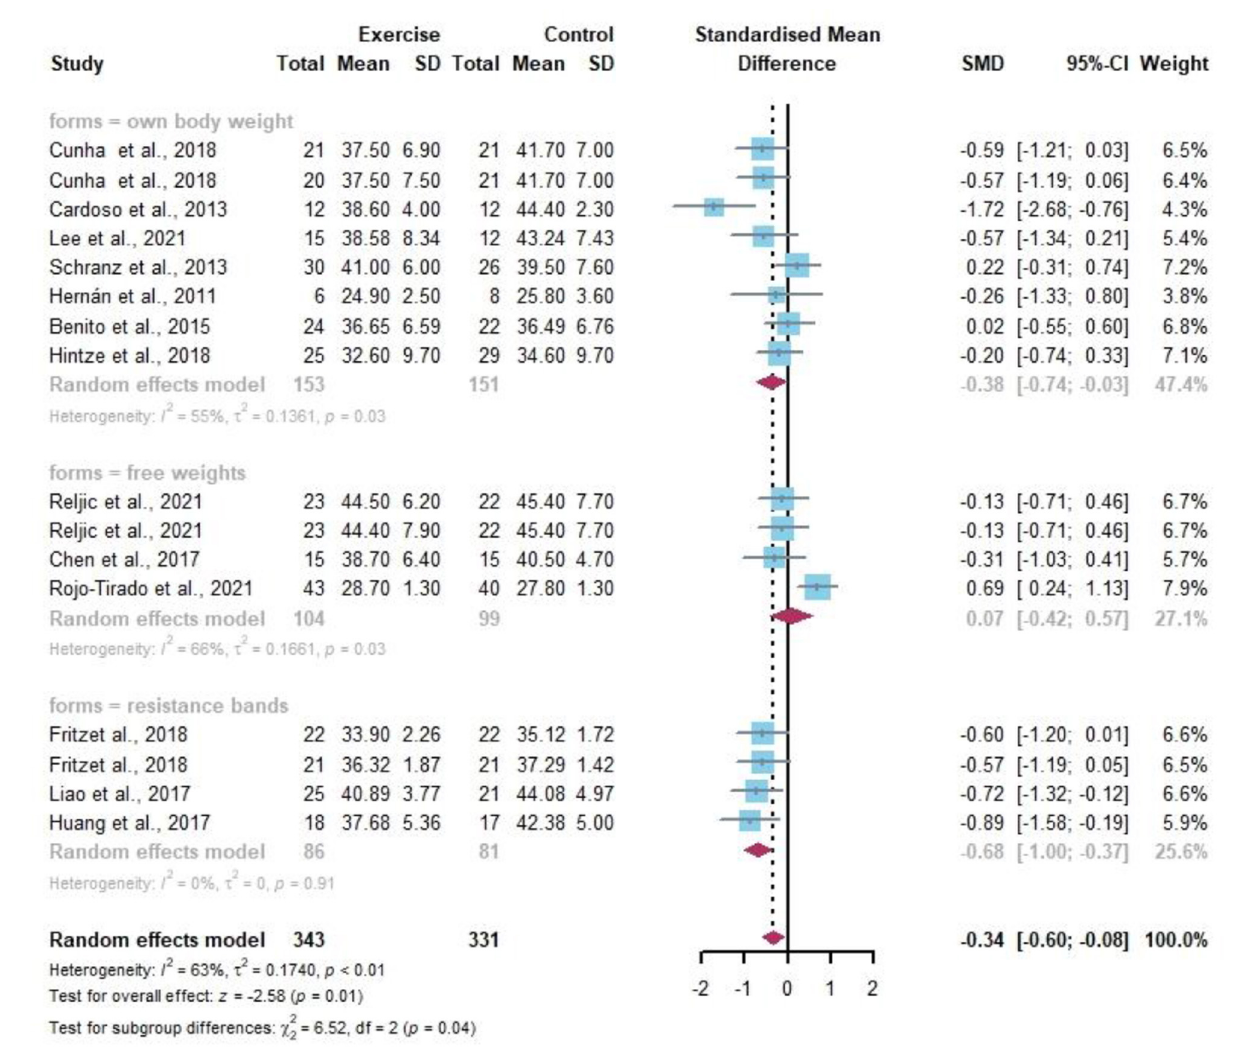
FIGURE 7 | Meta-analysis of effects of different resistance exercise forms on body fat (BF) of overweight and/or obese